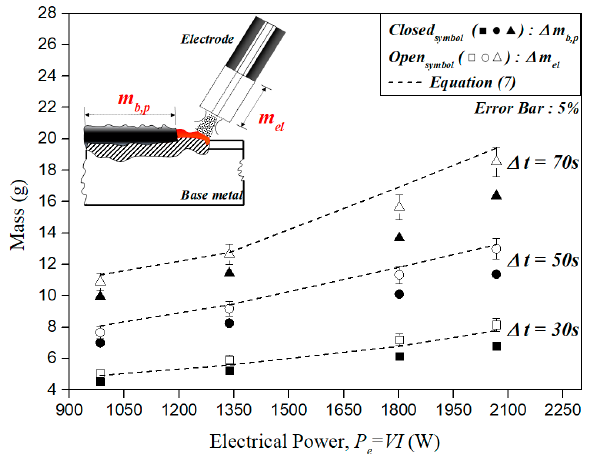
Figure 4. Experimental variation of Δ m el and Δ m b,p according to P e for Δ t = 30 s, 50 s, and 70 s.